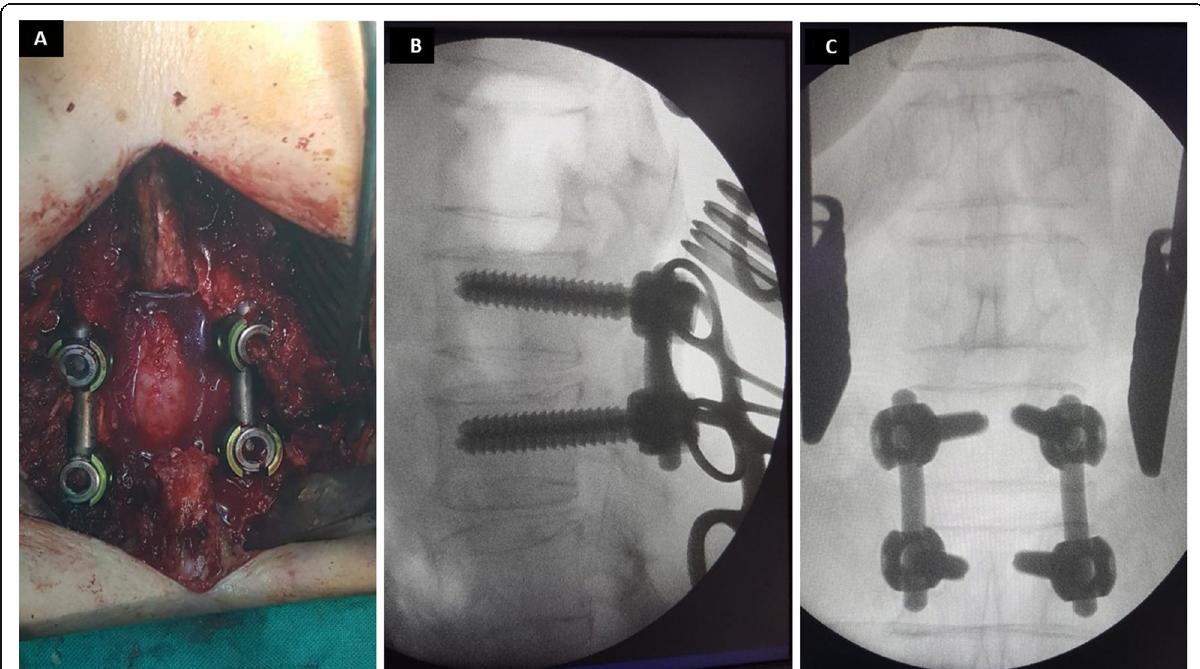
Fig. 2 Intraoperative of the same patient ( a ) showing the extent of the laminectomy and final transpedicular screw fixation. Intraoperative fluoroscopic images b lateral view and c AP view showing the accurate placement of the L1-L2 of the pedicle screw